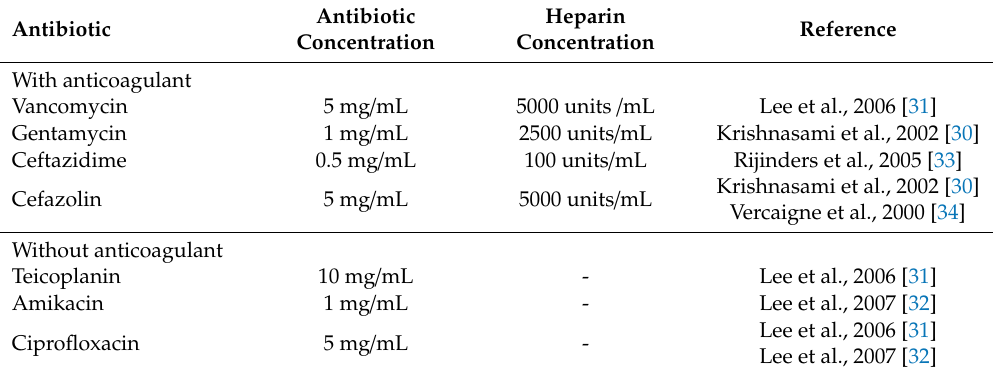
Table 1. Concentration of common antibiotic lock solutions used for the treatment of catheter-related bloodstream infection